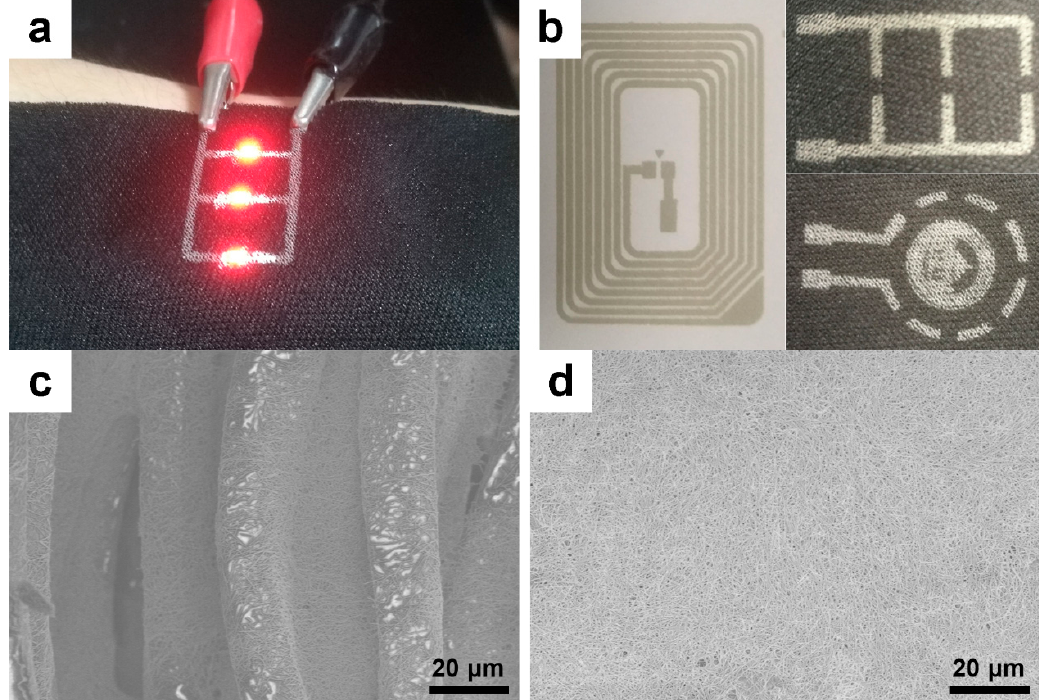
Figure 3. The photograph ( a – b ) of the screen printing patterns onto the textile (the LED can light on under the external applied voltage) and conventional paper, SEM images at different magnifications of the surface of printed layer ( c is the textile and d is